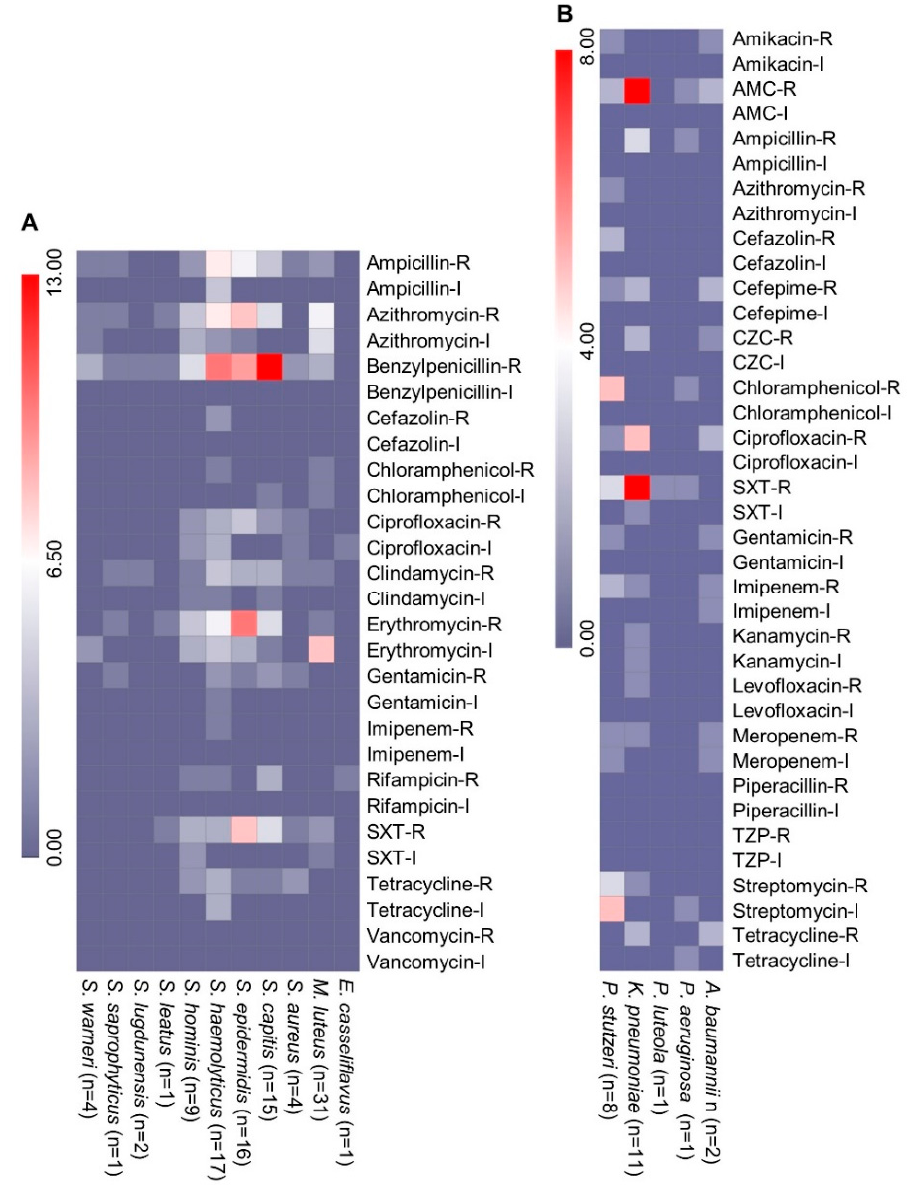
Figure 2. Antimicrobial susceptibility of the isolates from the hospital environment. ( A ) Antimicrobial susceptibility of Gram-positive bacteria and ( B ) Gram-negative bacteria. The scale is based on the number of isolates. R, resistant; I, intermediately resistant; SXT, trimethoprim/sulfamethoxazole; AMC, amoxicillin/clavulanic acid; TZP, piperacillin/tazobactam; CZC, ceftazidime/clavulanic acid; n, number of